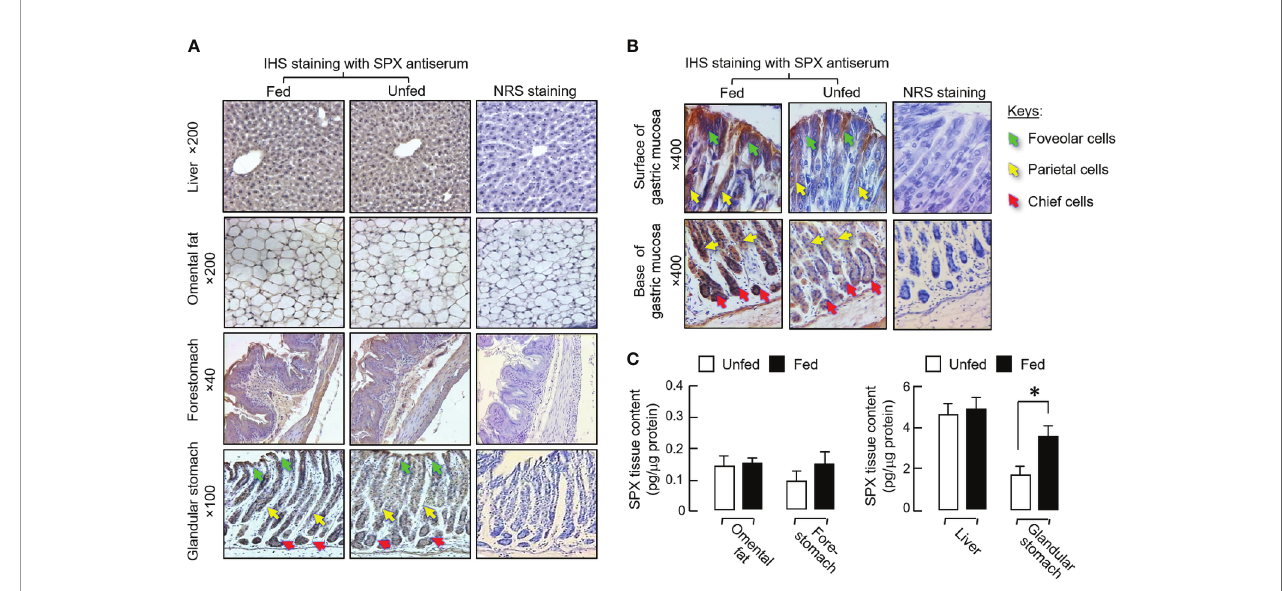
FIGURE 2 | Effect of food intake on protein expression of SPX at tissue level in mice. The feeding experiment was conducted as described in the preceding section with one group as the “ fed ” group (with food provision at 10:00 AM ) and the other as the “ unfed ” group (deprived of food supply). After 6 h with the respective feeding protocols, the liver, omental fat, forestomach and glandular stomach were excised and subjected to IHS staining with a SPX anti-serum (1:600) raised in rabbit (A) . Counter staining with hematoxylin was routinely performed and parallel staining with normal rabbit serum (NRS, 1:600) was used as the negative control. Notable changes in SPX staining were not apparent in the liver, omental fat and forestomach but intensi fi cation of SPX signals was noted in gastric mucosa of glandular stomach with food intake, especially in the foveolar cells, parietal cells and chief cells of the gastric glands (B) . In the same study, tissue lysate was also prepared from the samples freshly collected in the respective tissues and used for measurement of tissue SPX content (C) . In the graph presented, the group denoted by an asterisk (*) represents a signi fi cant different at p < 0.05 compared to the respective